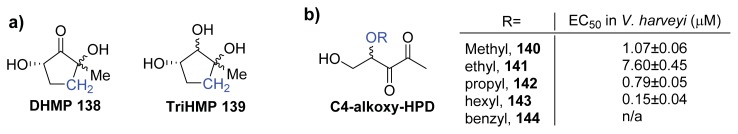
(a) Carbocyclic and (b) C4-alkoxy AI-2 analogs developed in Janda’s laboratory [63,64].